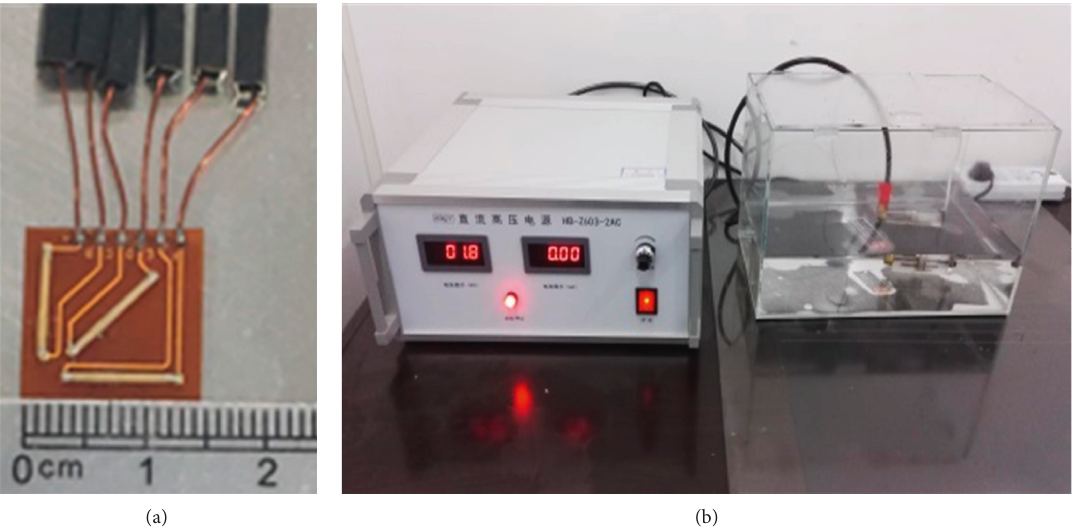
Figure 1: (a) Piezoelectric fiber rosette; (b) the homemade polarization device for the piezoelectric